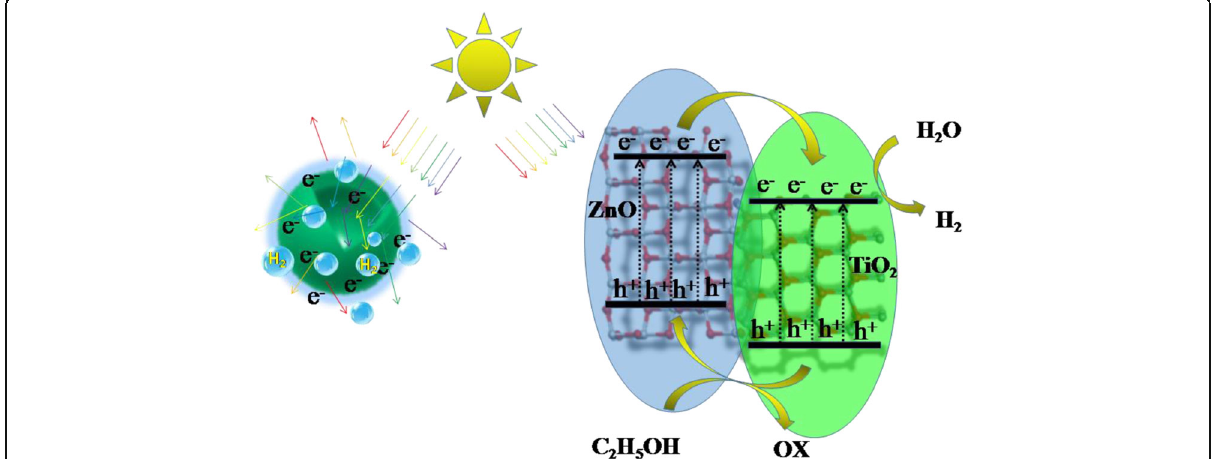
Fig. 6 Schematic illustration of the proposed HER mechanism of ZnO@TiO 2 hollow